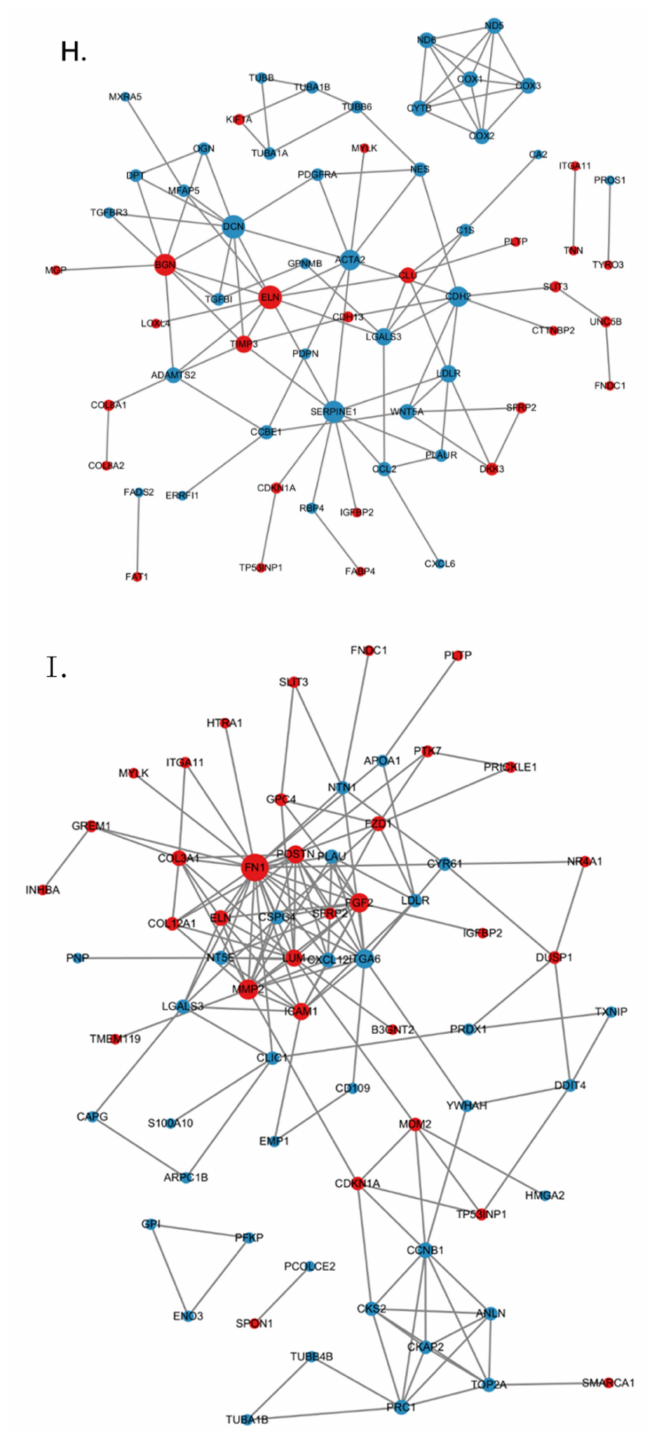
Figure 5. KEGG pathway analysis of DEGs in different comparisons. ( A ) Common DEGs. ( B – G ) Enriched KEGG pathway. ( H ) PPI network of 64 DEGs in the KO_LT versus WT_LT comparison. ( I ) PPI network of 66 DEGs in the KO_LT versus KO comparison. Red indicates up-regulated genes, and blue represents down-regulated